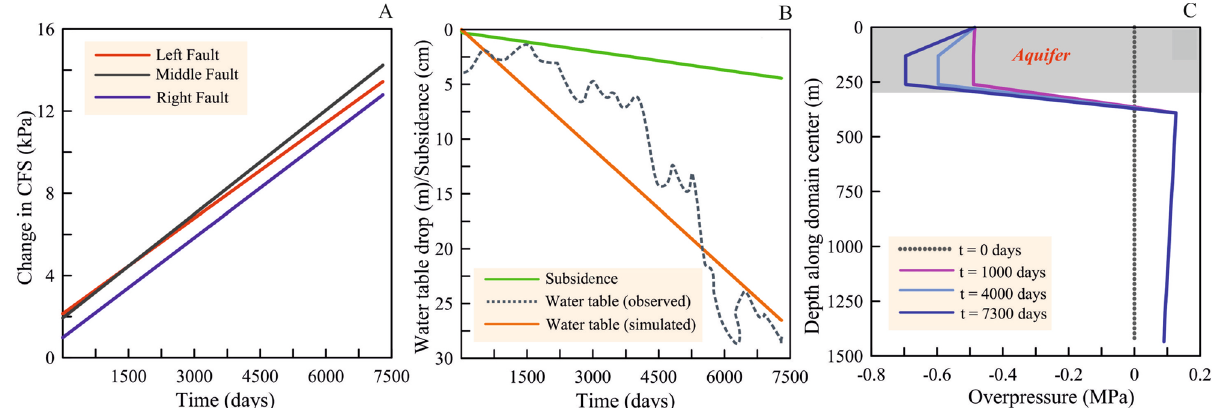
Figure 6. Fault stability, water table drop, ground subsidence and overpressure. (A) Change in fault stability due to water table drop is shown in terms of the change in Coulomb failure stress (CFS, in kPa) on the three faults at a depth of 10 km. Positive values correspond to destabilization and negative values correspond to stabilization. All faults experience destabilization under the reverse faulting mechanism. (B) Observed and simulated water table drop are consistent with each other. Ground subsidence increases at a rate of ~ 0.2 cm/year due to groundwater extraction. (C) Overpressure with depth along the model center at different times. Overpressure is shown over the 0–1.5 km depth interval which includes the 15 layers of the aquifer within 0–300 m interval (see also supplementary Figures). This figure was generated using Grapher graphical application (version 8.7.844